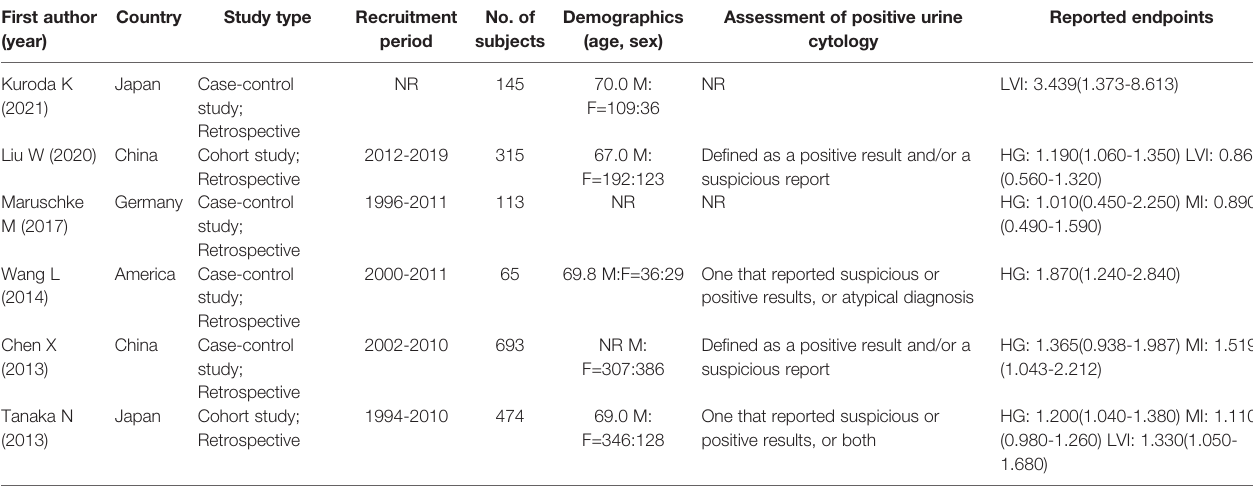
TABLE 7 | Main characteristics of studies about tumor malignant biological behaviors included in the